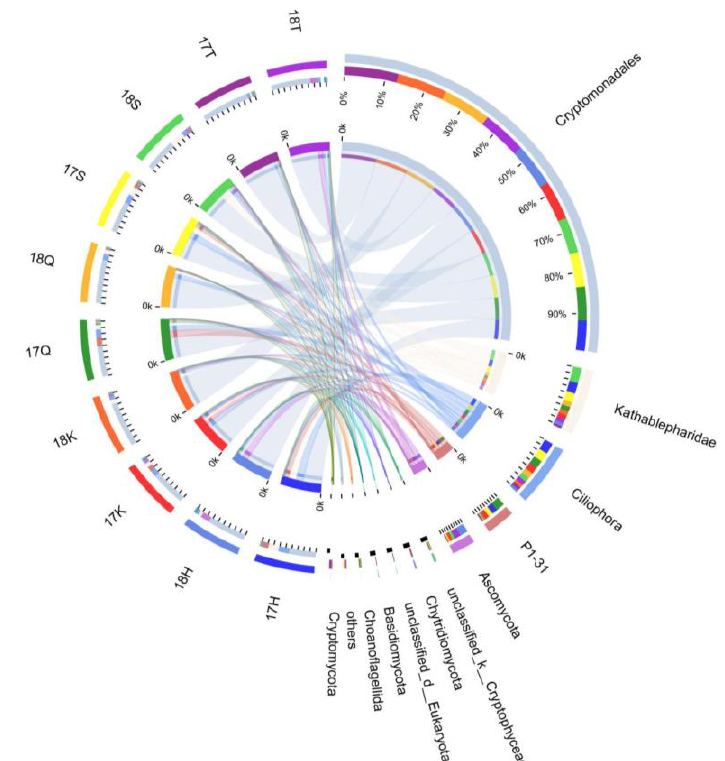
Figure 4. Samples correspond to the relative abundance of planktonic eukaryote sequences at the phylum level. In the Circos diagram, the small semicircle on the left represents the phylum composition of the sample, the color of the outer band represents the sampling site, the color of the inner band represents the phylum, and the length represents the relative abundance of the phylum in the corresponding sample. The large semicircle on the right represents the proportional distribution of each phyla in the different samples, the outer band represents the phyla, the inner band represents the different sites, and the length represents the proportional distribution of the sequences of each phylum that were from each sample.